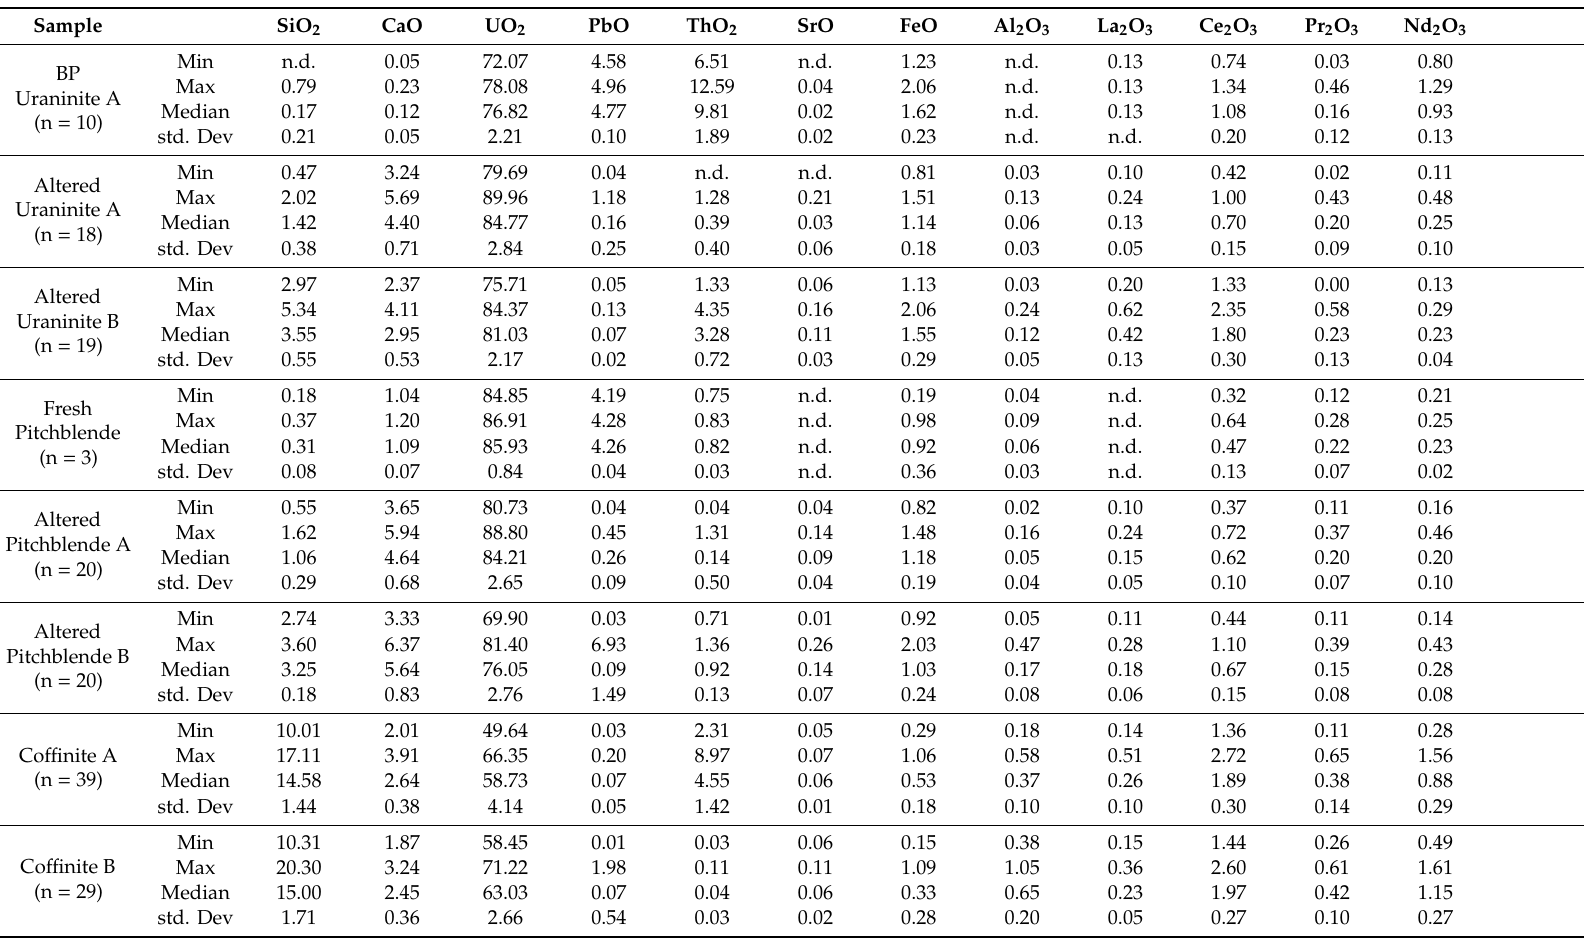
Table 1. Composition of uraninite, pitchblende, and co ffi nite in the Jiling uranium deposit (oxide concentrations are in wt.%, with min, max, and median value).